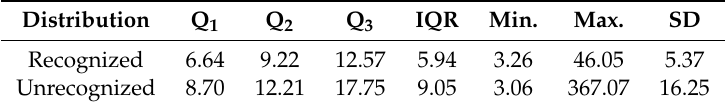
Figure 10. Distribution of the perplexity presented by the 10-gram character Language Model (LM) per recognized and unrecognized OOV words (decomposed into character sequences) by the HMM system. Table 3. Features of the perplexity per OOV word recognized and unrecognized distributions for the HMM character-based 10-gram LM. Q 1 , Q 2 and Q 3 are respectively the 1th, 2nd and 3rd quartile, IQR the interquartile range, Min. and Max. the minimum and maximum values and SD the standard deviation. Distribution Q 1 Q 2